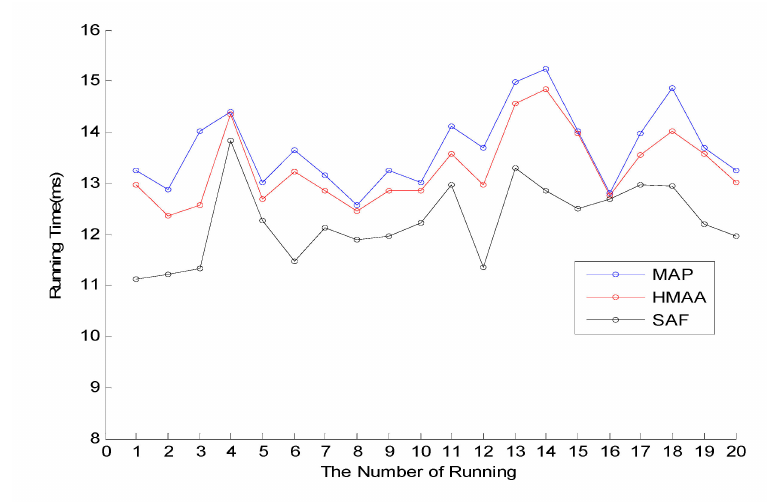
Figure 3. Running Time vs. the number of running for MAP, HMAA and SAF.